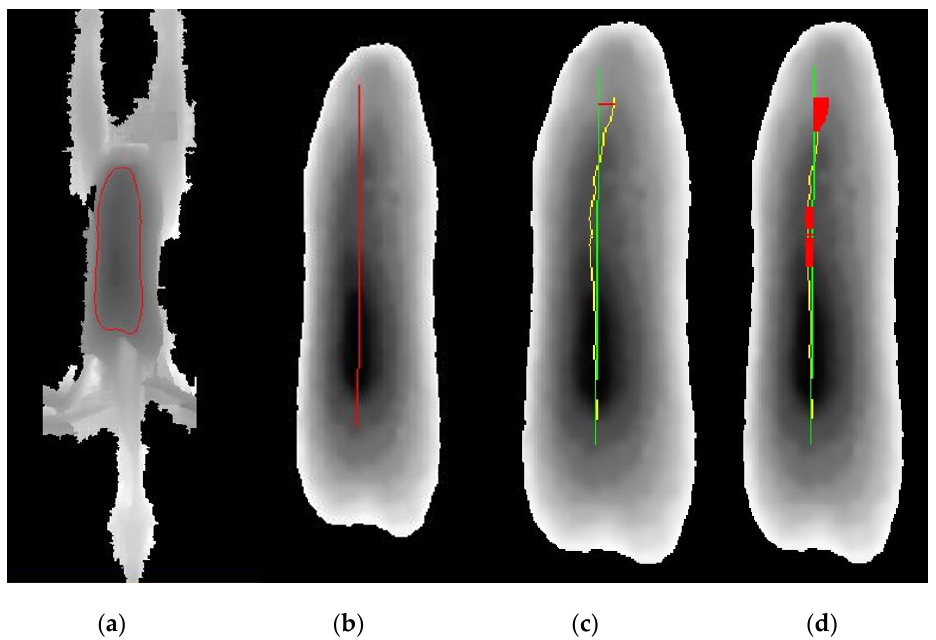
Figure 2. Image examples used for the automatic scoring of keel bones of laying hens at the slaughter line. Image ( a ) shows the keel area. Image ( b ) the straight main axis and ( c ) the deviation (yellow line). Image ( d ) shows in red the detected deviation.